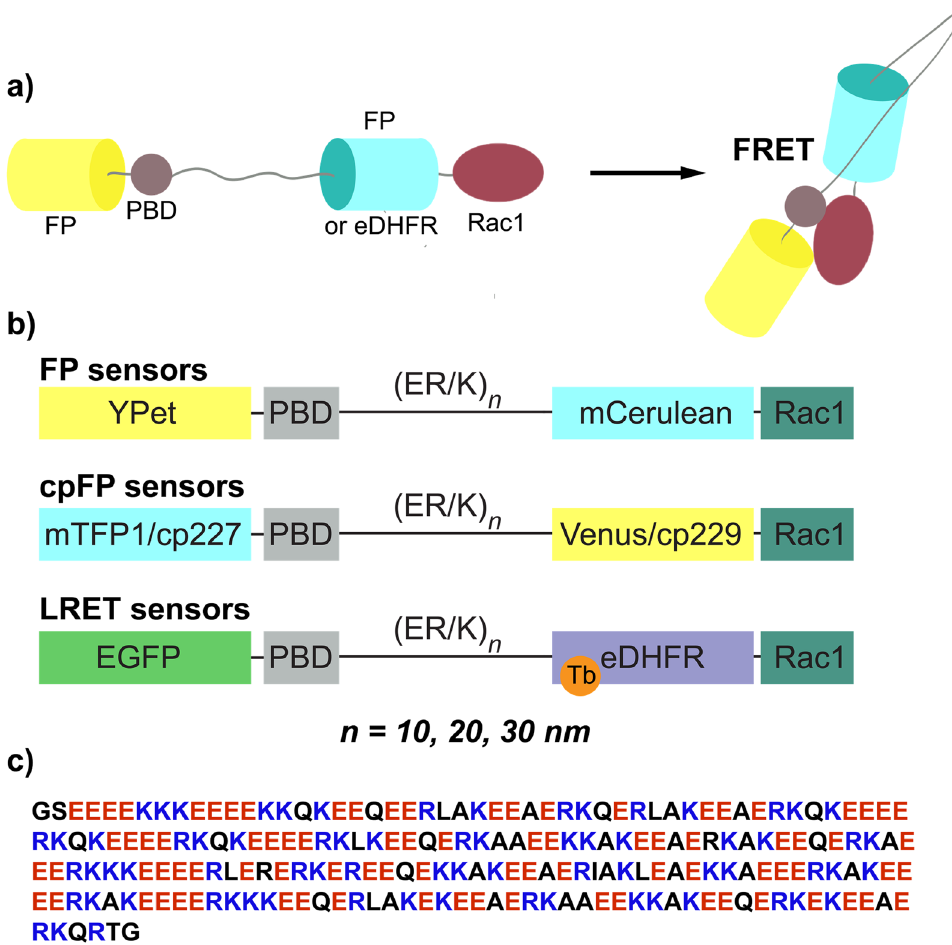
Figure 1. Design of FRET and LRET Rac1 biosensors. ( a ) Schematic representation and ( b ) mammalian expression constructs of single-chain FRET or LRET Rac1 biosensors. A series of nine sensors was constructed in which alpha-helical ER/K linkers of different length (10 nm, 20 nm and 30 nm) were combined with three fluorophore pairs: (i) mCerulean and Ypet; (ii) circularly permutated mutant (cp227) of mTFP1 and circularly permutated mutant (cp229) of Venus; (iii) Tb(III) complex (bound to E. coli dihydrofolate reductase, eDHFR) and EGFP. ( c ) Sequence of a 30 nm alpha-helical ER/K linker (207 residues) that includes alternated repeats of approximately four negatively charged glutamates (red) and four negatively charged arginines or lysines (blue). The linker is rigid to keep protein components far apart in OFF state. Stochastic breaks allow protein interaction in the biosensor ON-state and promote a large change in donor-sensitized acceptor